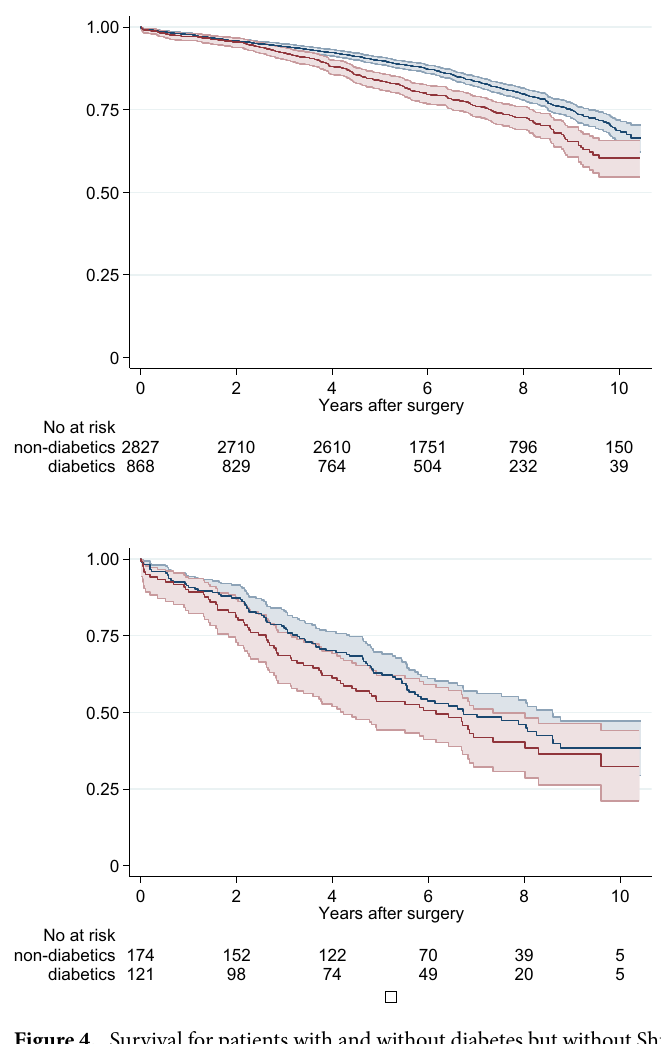
Figure 4. Survival for patients with and without diabetes but without Shrunken Pore Syndrome after elective cardiac surgery are seen in top graph and with Shrunken Pore syndrome are seen in lower graph, diabetic; red solid line, non-diabetic; blue solid line. Faded area represents 95%